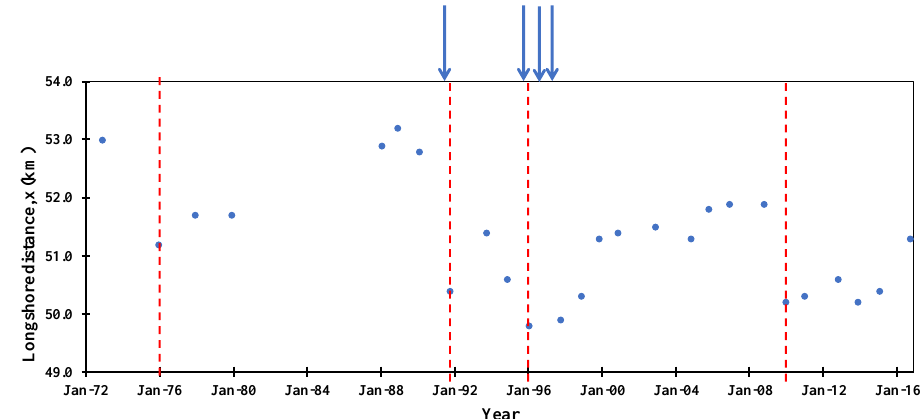
Figure 11. Location of Reju River mouth (blue circles) from 1972 to 2016. Red dashed lines indicate breachings, and blue arrows represent cyclone events.